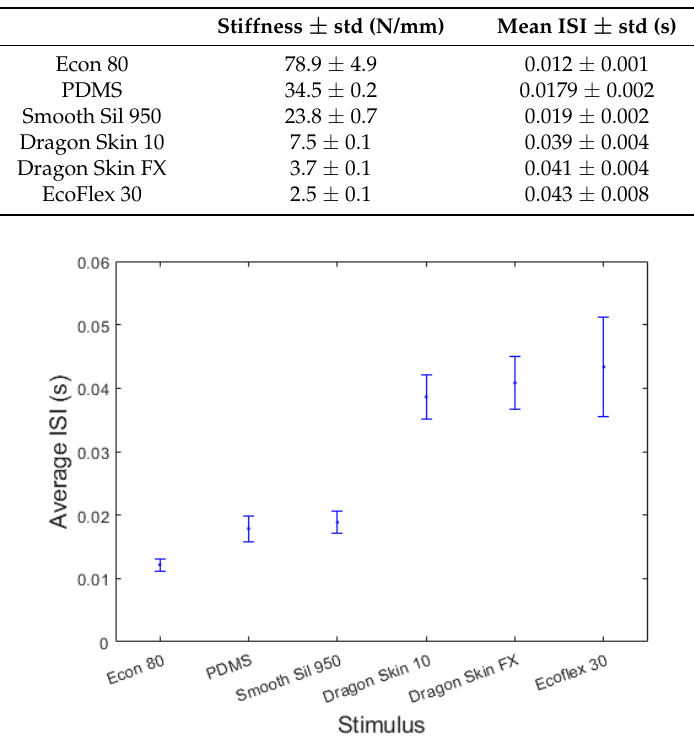
Figure 6. Experimented stimuli sorted from the stiffer to the more compliant, and related inter-spike interval. Error bars show the standard deviation of the inter-spike interval (ISI).